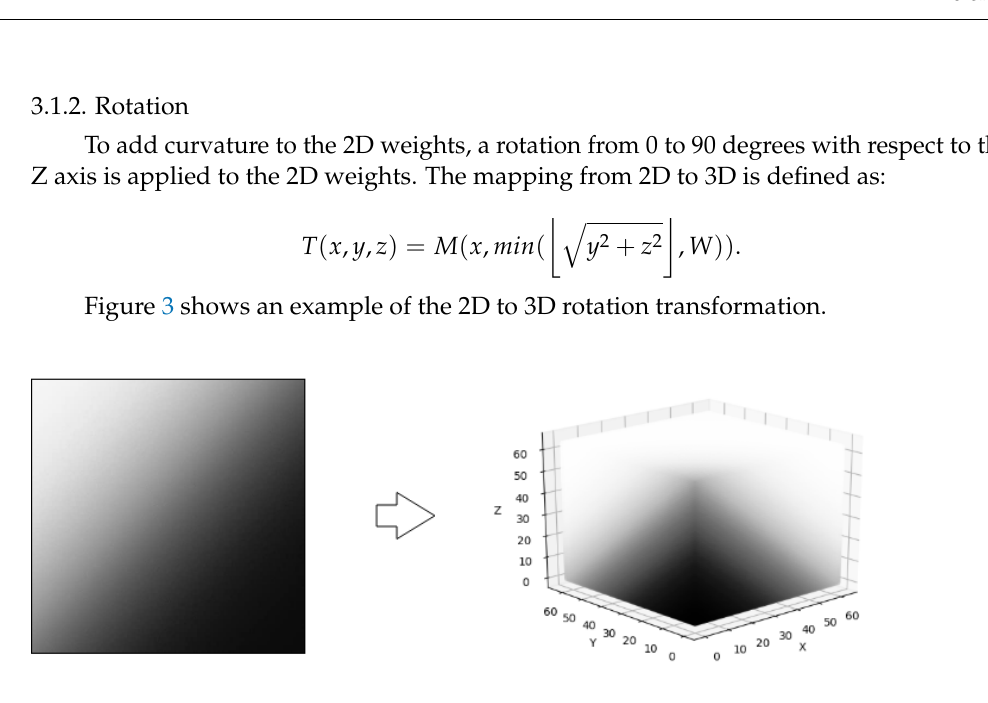
Figure 3. Rotation on Z axis of a 2D matrix to generate a 3D tensor.